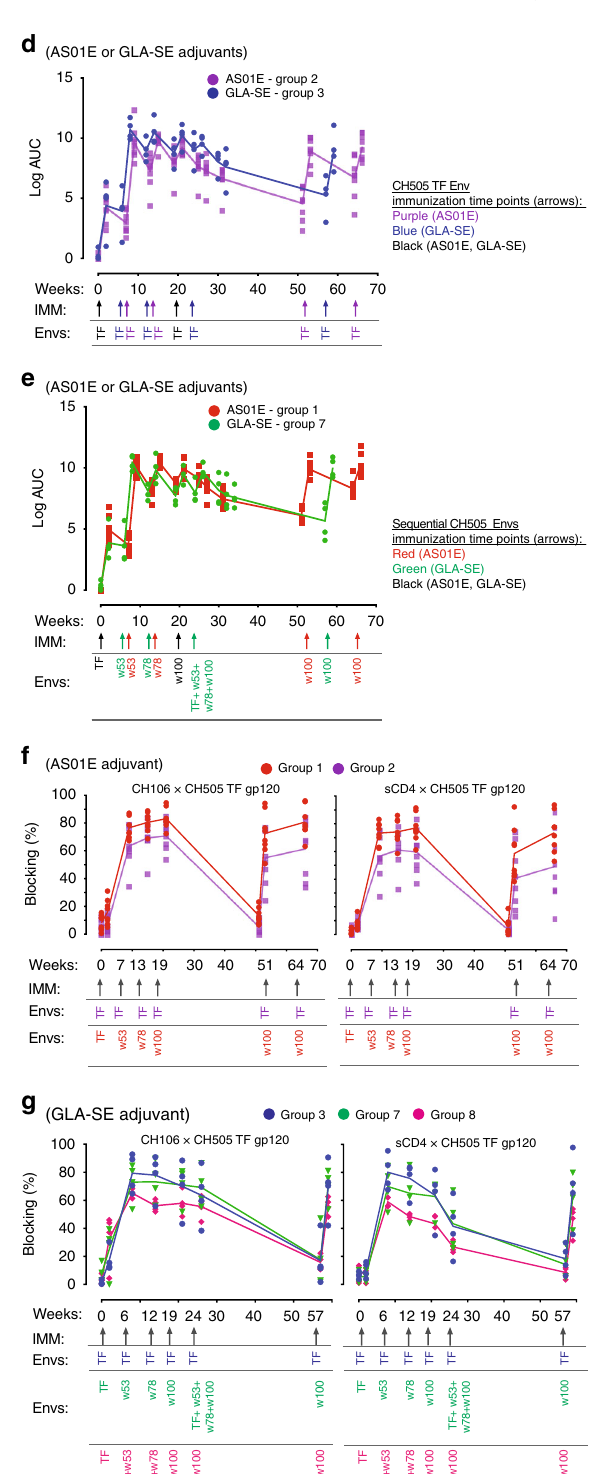
(AS01E or GLA-SE adjuvants)